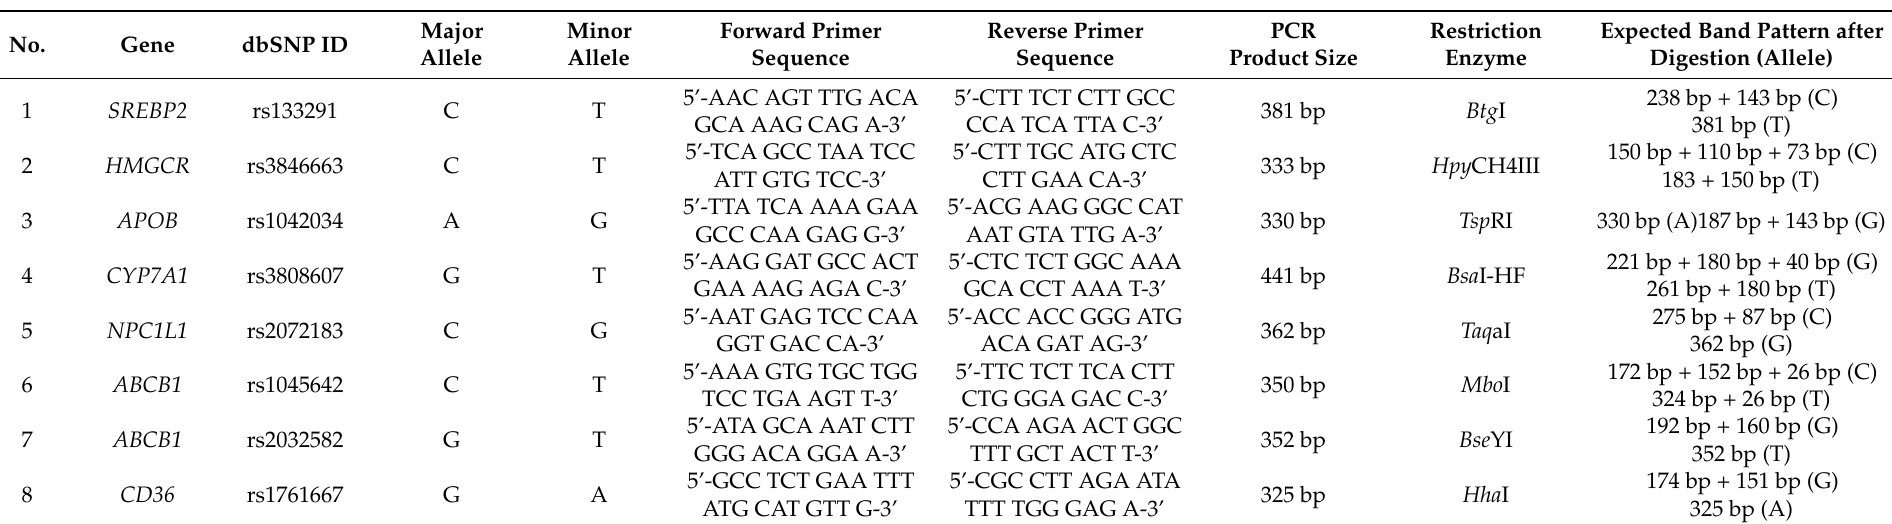
Table 1. Sequences of the specific primers and restriction enzymes used for polymerase chain reaction (PCR)-restriction fragment length polymorphism (RFLP) genotyping.